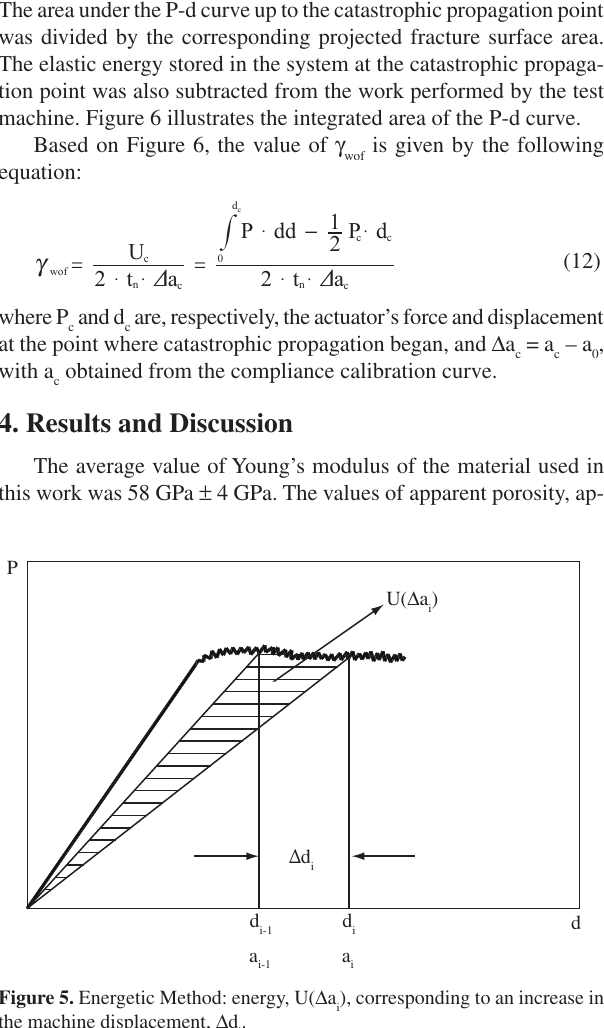
Figure 5. Energetic Method: energy, U( D a the machine displacement, D d